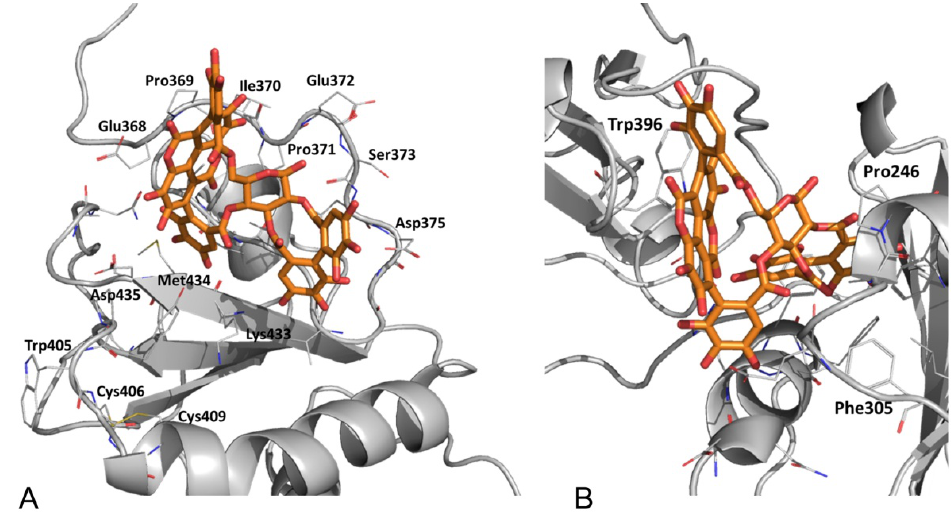
Figure 7. Top-ranked β -punicalagin binding modes on ( A ) PDIA3 a’ domain ( − 39.2 kcal mol − 1 ) and ( B ) PDIA1 a’ domain ( − 35.2 kcal mol − 1 ).